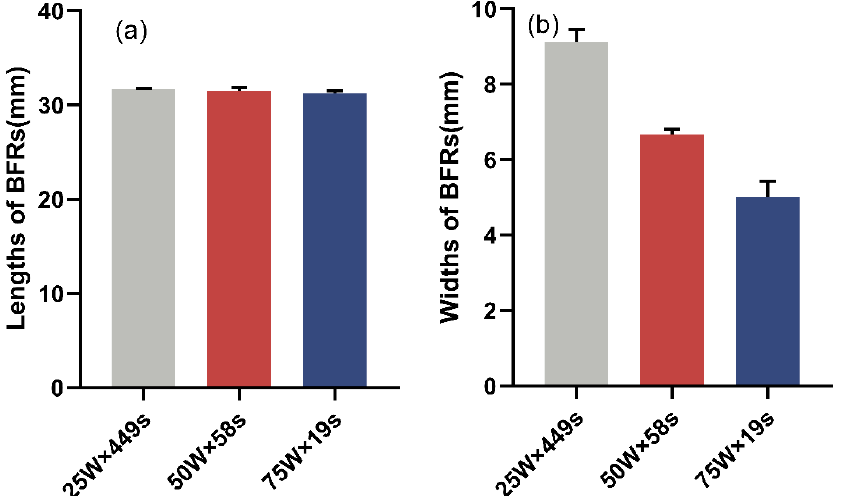
Figure 8. BFRs of phantom after ultrasonication with di ff erent combinations of acoustic power and time: ( a ) 25 W × 449 s, ( b ) 50 W × 58 s, ( c ) 75 W × 19 s. It could be seen from Figure 9 that in the phantom experiment, HIFU needed 448 s to induce a BFR with a length of 31.58 mm with an acoustic power of 25 W, and this BFR’s width was 9.17 mm, and the axis length ratio was 3.45, which was far from the axis length ratio of the AFR. The axis length ratio was 5.97 with an acoustic power of 75 W, and the shape of the BFR was closer to that of the AFR, and the exposure energy required was re- duced by 87.38%.